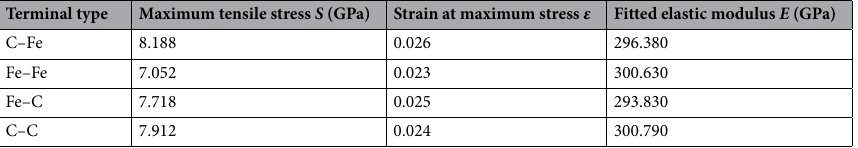
Table 6. Mechanical parameters during axial